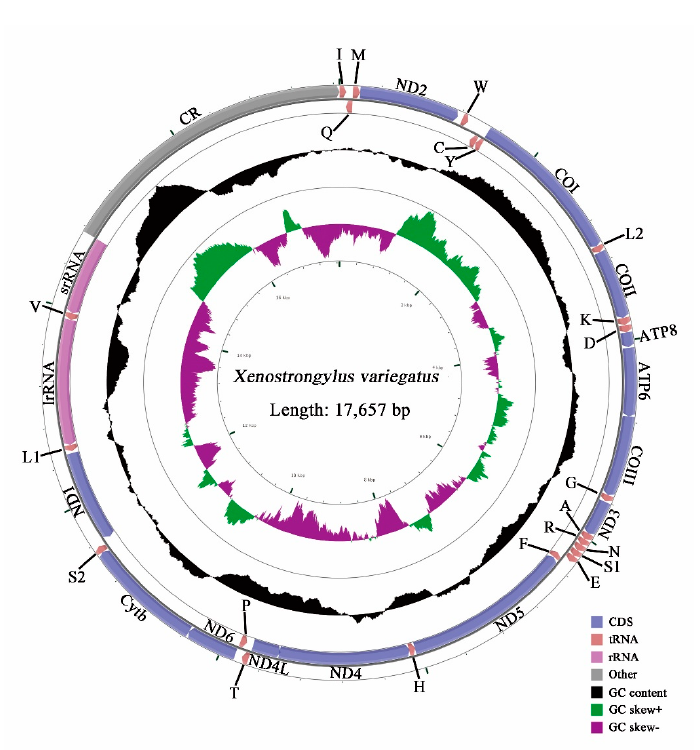
Figure 1. Mitochondrial map of X. variegatus.